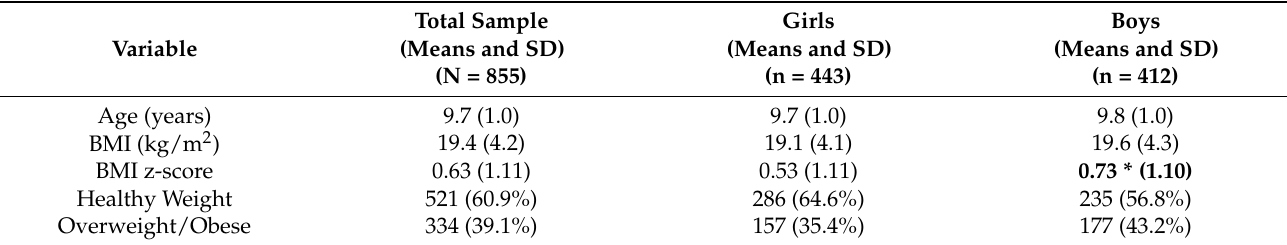
Table 1. Descriptive statistics for the total sample and within sex-specific